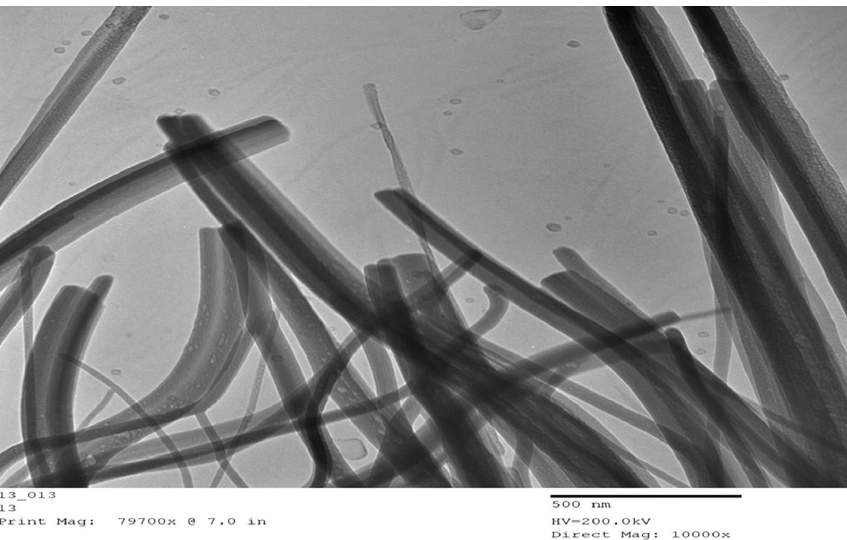
Figure 4: TEM photograph of synthesized G-ZnO NPs via the sol-gel